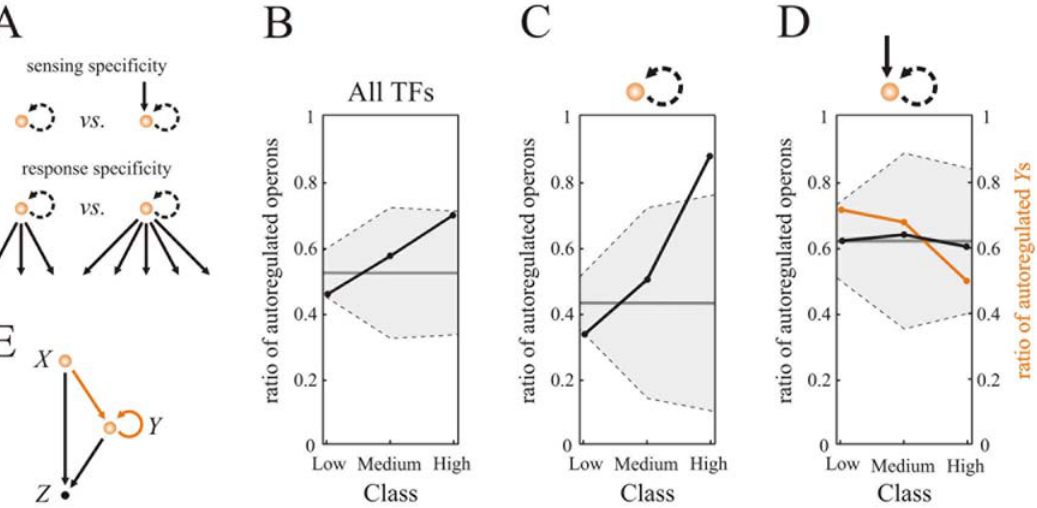
Figure 1. Distribution of autoregulation. (A) Sensing specificity (presence/absence of external regulation) and response specificity (regulon size). (B–D) Abundance of autoregulation in three TF response specificity classes quantified by regulon size. This includes first an analysis including all network TFs (B), followed by two more examinations considering those subsets of TFs without (C) or with (D) upstream transcriptional control, respectively. Classes: low (one to four regulated operons), medium (five to nine) or high (ten or more, considered as TF hubs). We also plotted the null behavior obtained by random sampling of the corresponding class –preserving group size– within the specific TF group (B,C, or D), 10 000 times (mean, continuous gray line, 6 2 standard deviations, shaded area). Lines between points to help visualization. (E) Autoregulated TFs with upstream regulation as part of a FFL, a motif constituted by three elements X , Y , and Z , two of them being always a TF in this context ( X and Y ). In (D), the ratio of autoregulated Y for each specificity class is also showed (orange), see main